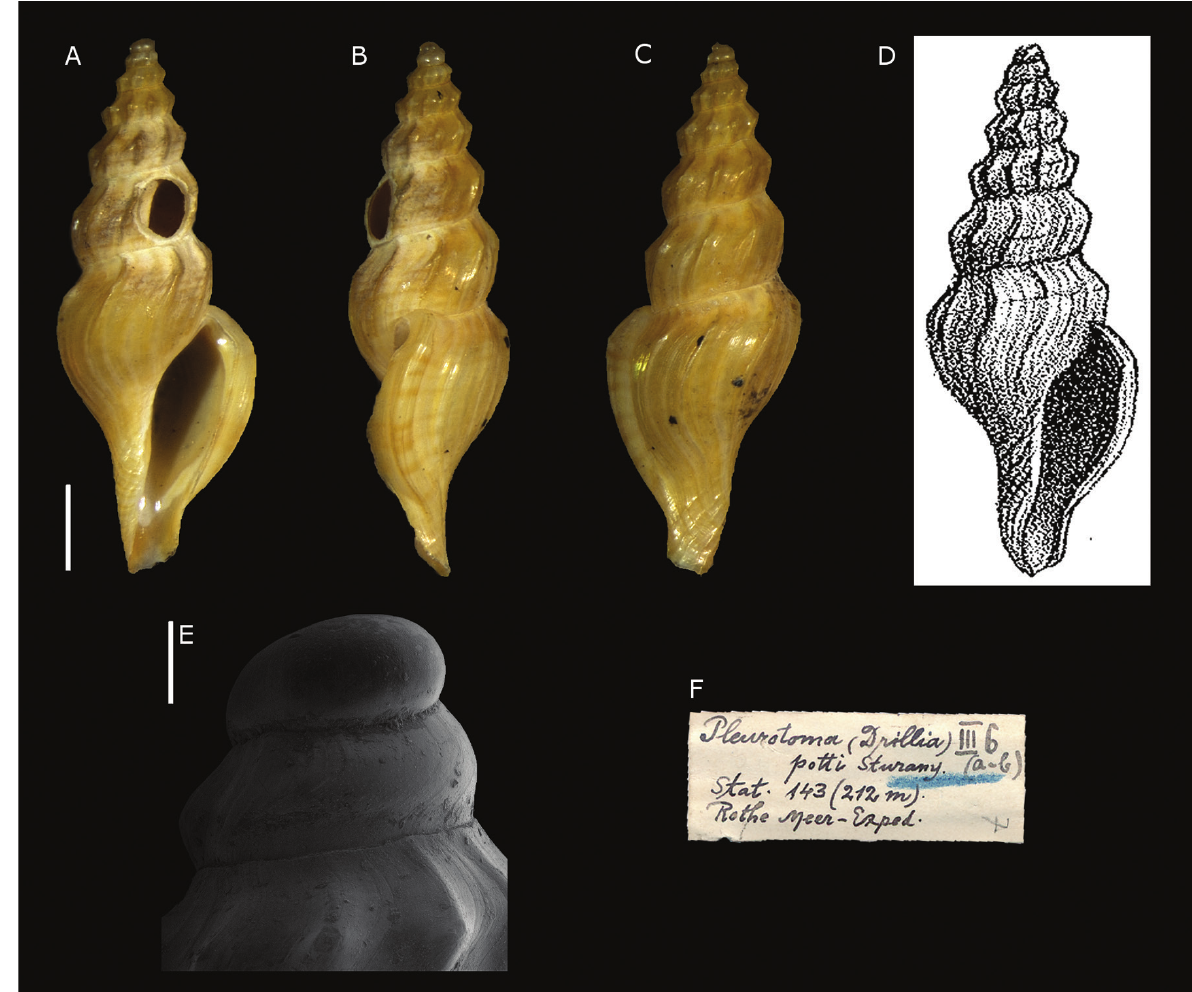
Figure 21. Pleurotoma potti Sturany, 1900, Station 143 (Harmil Island, Dahlak Archipelago, Eritrea, Red Sea). A–C, E . Holotype, NHMW 84250: front ( A ), right side ( B ), back ( C ), protoconch ( E ). D . Original figure by Sturany (1903). F . Original holotype label. Scale bars: A–C : 2 mm, E : 0.2 mm.